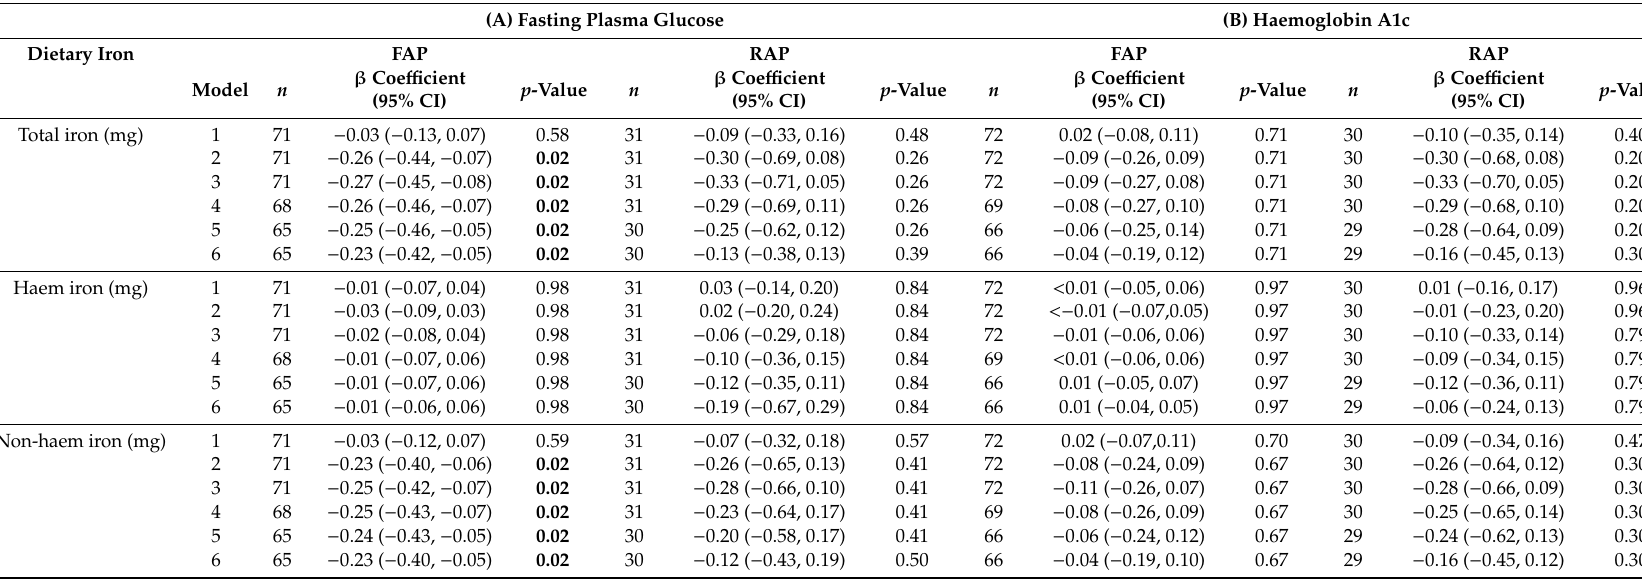
Table 4. Association between (A) fasting plasma glucose, (B) haemoglobin A1c and dietary iron in sub-groups stratified by the recurrence of acute pancreatitis. (A) Fasting Plasma